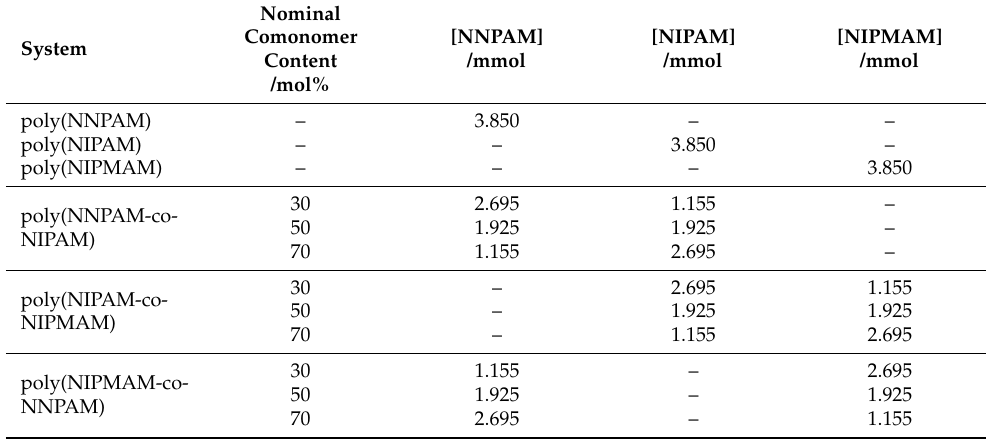
Table 4. List of the molar quantities of the monomers used for the respective homo- and copoly- mer microgels synthesized. The nominal comonomer content is related to the total amount of monomers